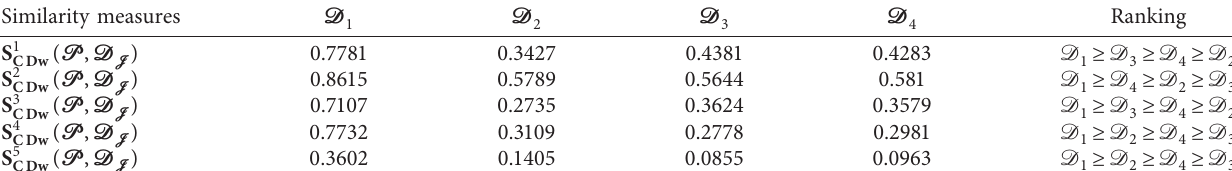
, ϕ ) � ( 0 . 5 , 0 . 5 ) cc cc